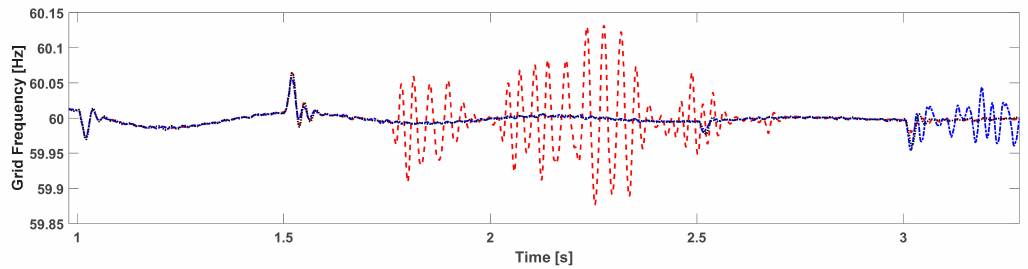
Figure 24. Secondary current of transformer during faulty operation (80% power-loss fault).